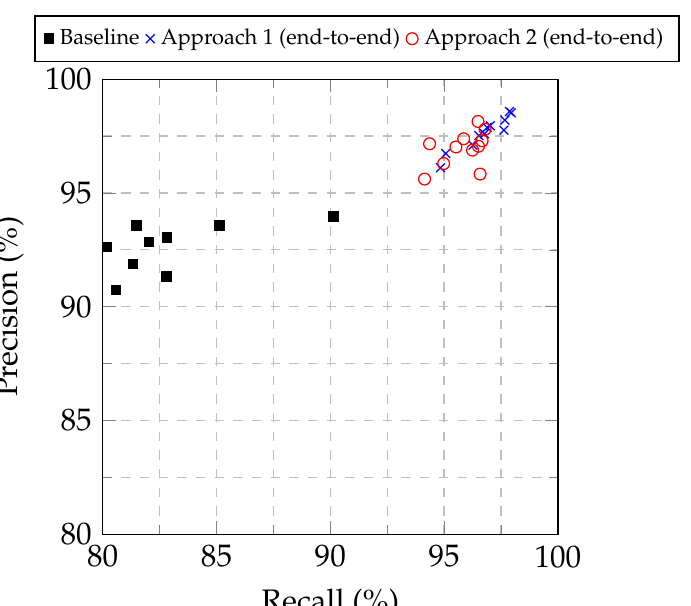
Figure 3. Precision vs. recall for the baseline approach and Approaches 1 and 2 for end-to-end training.